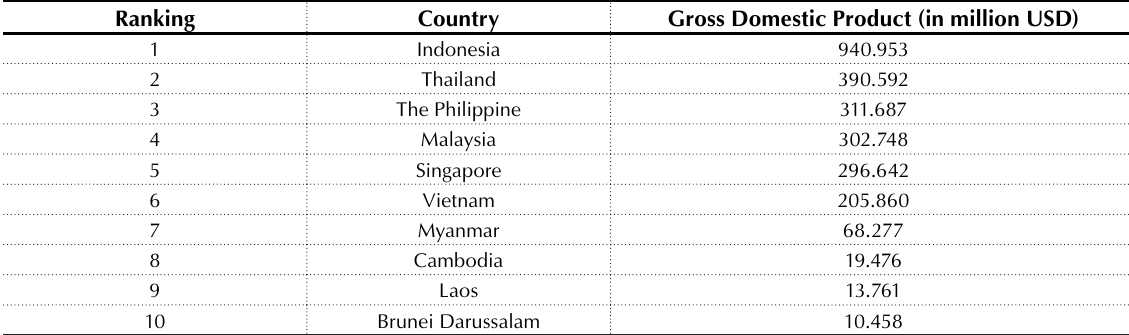
Source: ASEANstats